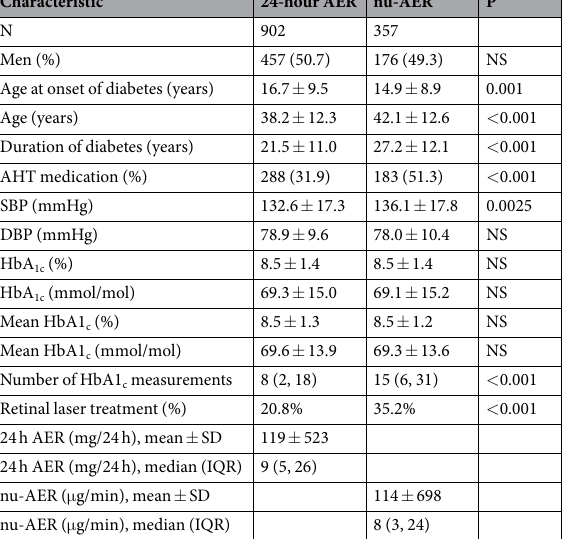
Table 1. Characteristics of the novel replication patients. Characteristics were collected at the same visit as the 24-hour/nu-AER. Mean HbA 1c refers to mean of all available HbA 1c since the onset of diabetes. Data are given as numbers (percent), or mean ± standard deviation (SD), or medians (interquartile range [IQR]). AHT: anti-hypertensive. SBP: systolic blood pressure; DBP: diastolic blood pressure. P: difference between the replication sets; p-values > 0.05 are indicated as non-significant (NS); calculated with Welch two sample t-test for continuous variables, and Pearson’s Chi-squared test for binary